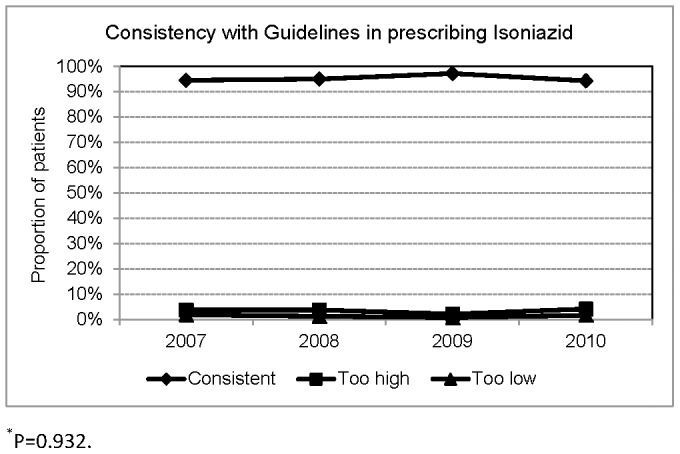
Consistency with Taiwan Guidelines in prescribing Isoniazid.